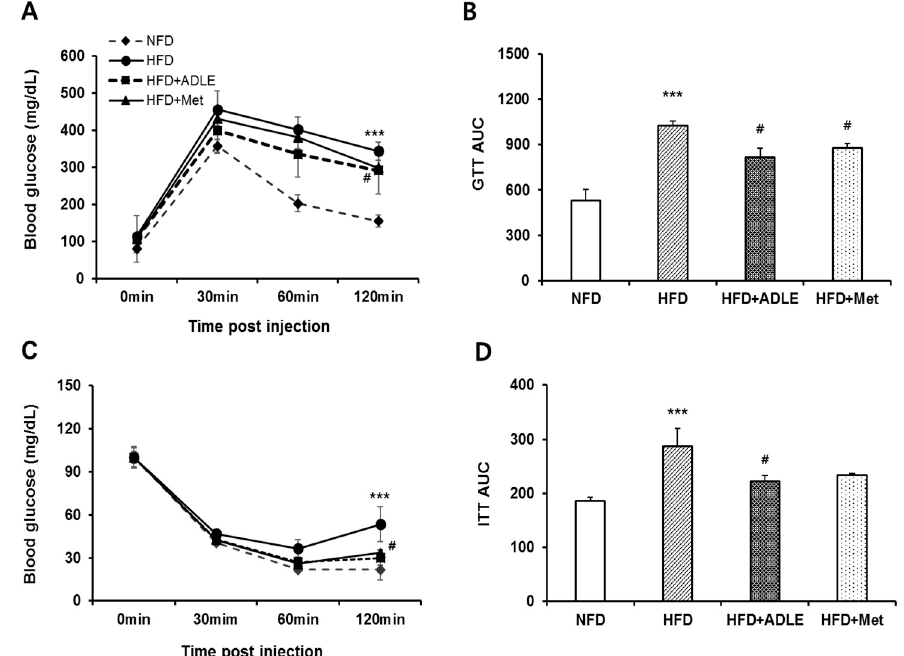
Figure 2. Treatment of ADLE improved glucose and insulin tolerance of HFD-induced diabetic mice. Mice were treated as described in Figure 1. ( A ) Intraperitoneal glucose tolerance test (GTT), ( B ) area under the curve (AUC) of GTT, ( C ) intraperitoneal insulin tolerance test (ITT), and ( D ) area under the curve (AUC) of ITT. Values are presented as mean ± SD ( n = 6–8). *** p < 0.001 vs. NFD group. # p < 0.05 vs. HFD group. NFD, normal-fat diet; HFD, high-fat diet; HFD + ADLE, high-fat diet + ADLE; HFD + Met, high-fat diet + Met.